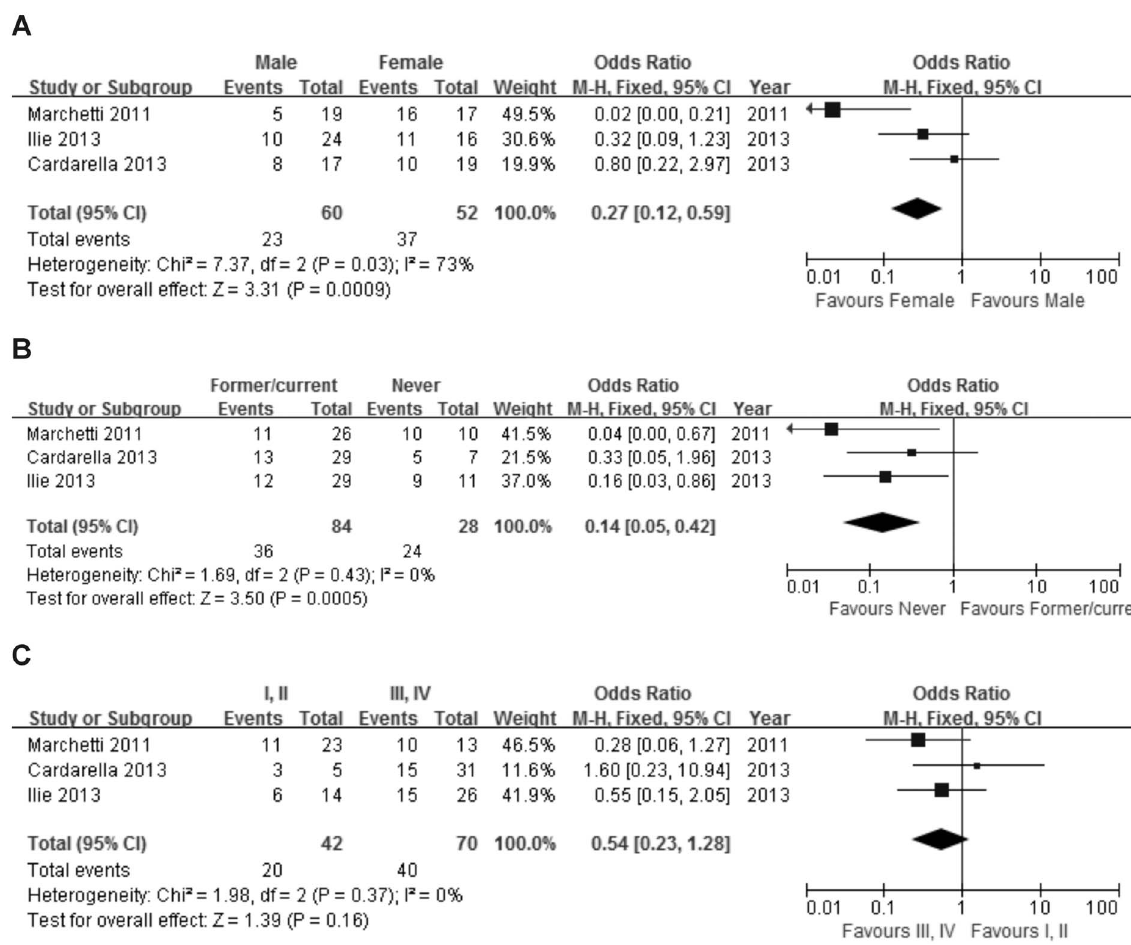
Figure 3. The association of BRAF V600E mutations with gender (A), smoking (B) and stage (C).